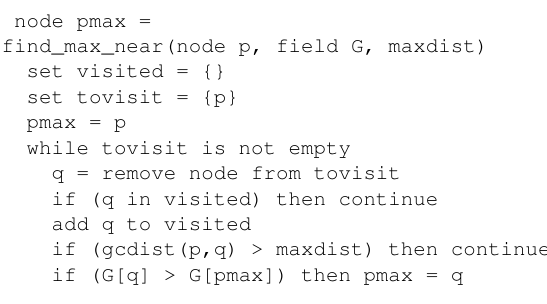
Figure 51. An example node graph describing an unstructured grid